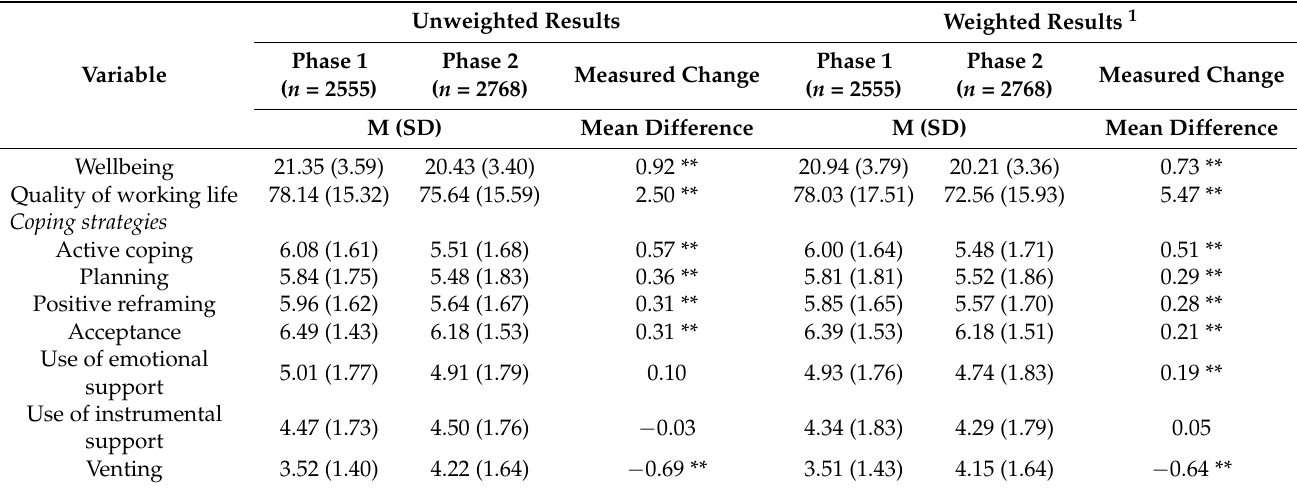
Table 2. Descriptive statistics for key study variables and their comparison between Phase 1 and Phase 2 of the study.